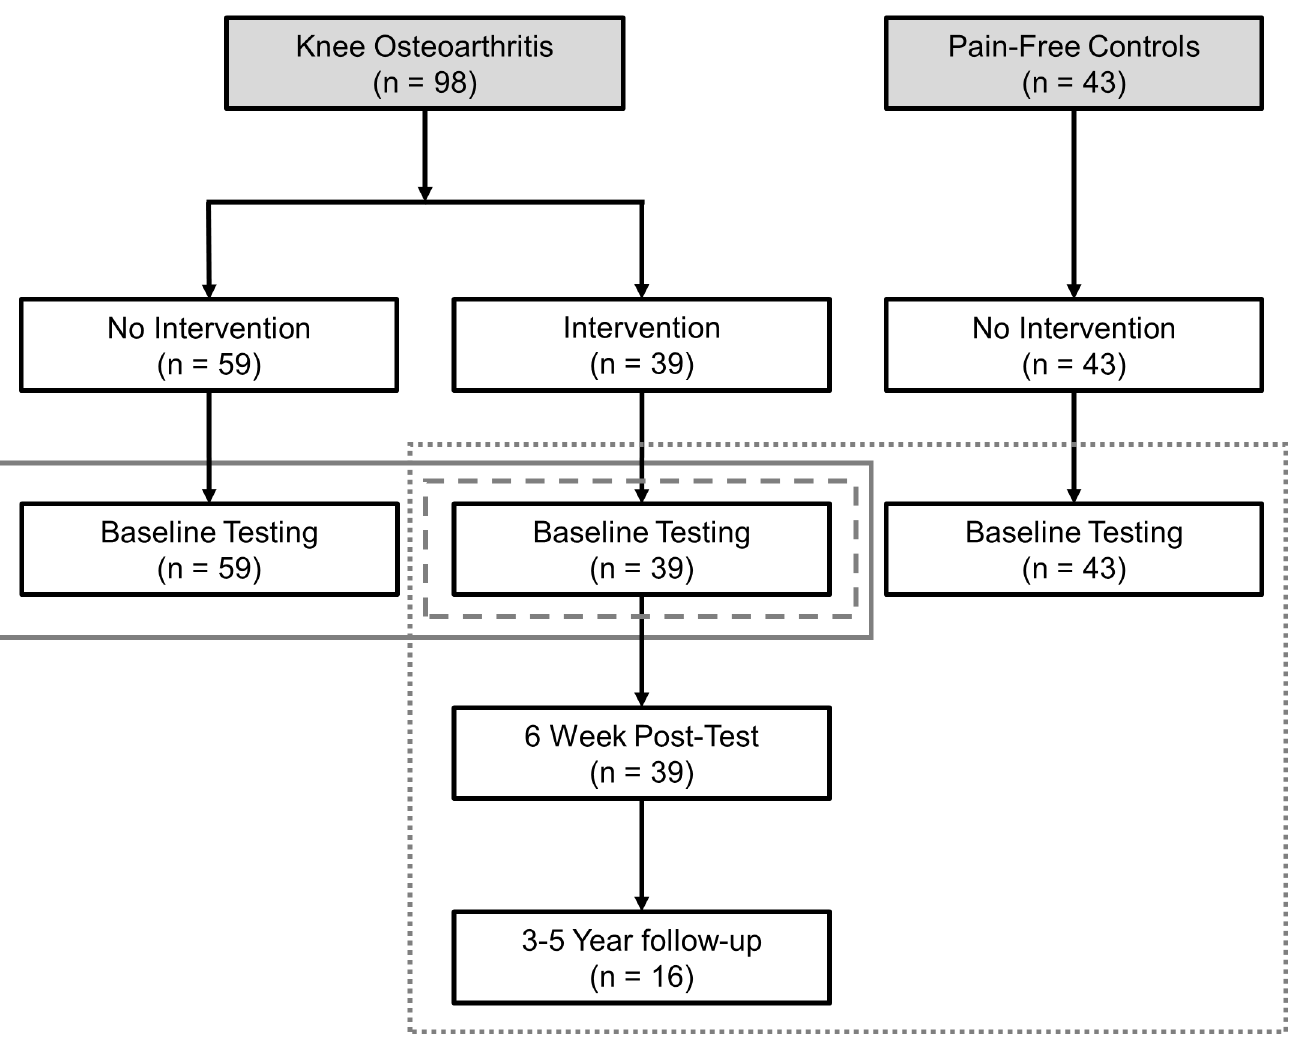
Fig 1. Flowchart illustrating the testing of patients with knee OA and pain-free controls. The three outlining boxes depict use of participants for data reduction (solid), classification algorithm (dashed), and projection in classification subspace